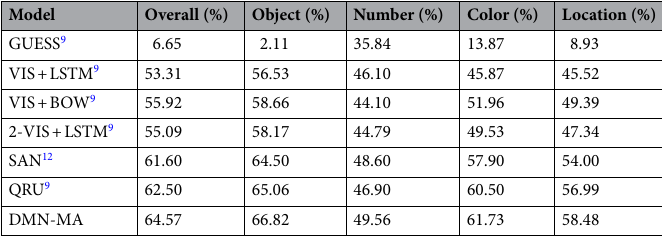
Table 2. Accuracy compared to other methods in COCO-QA dataset.